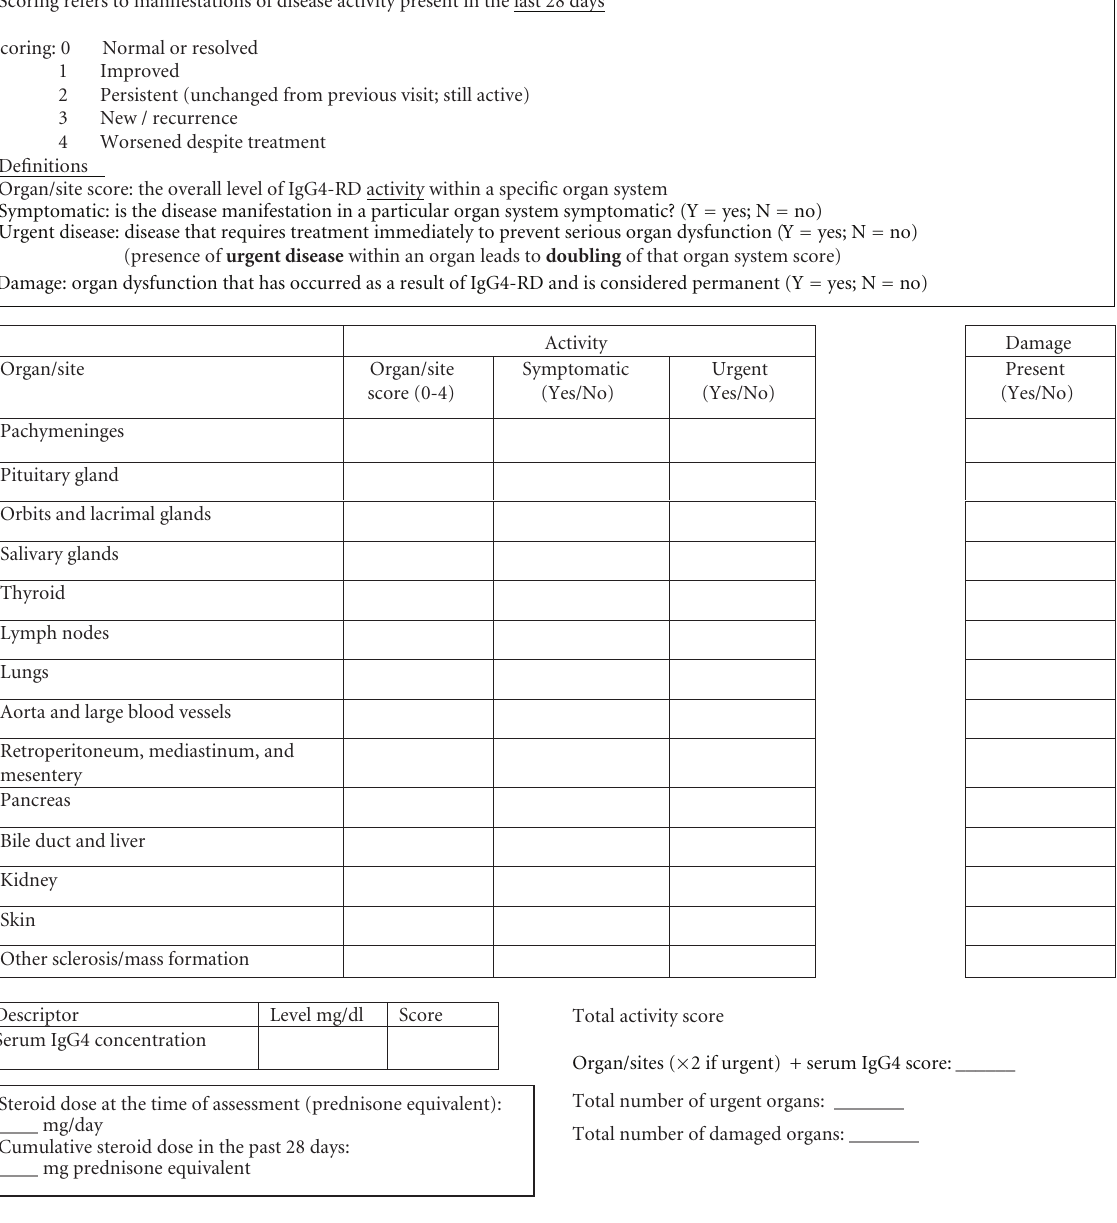
Figure 1: IgG4-related Disease Responder Index (IgG4-RD RI) Scoring Sheet this is a sample sheet of the IgG4-RD RI on which physicians score patient’s disease activity at a given clinic visit.